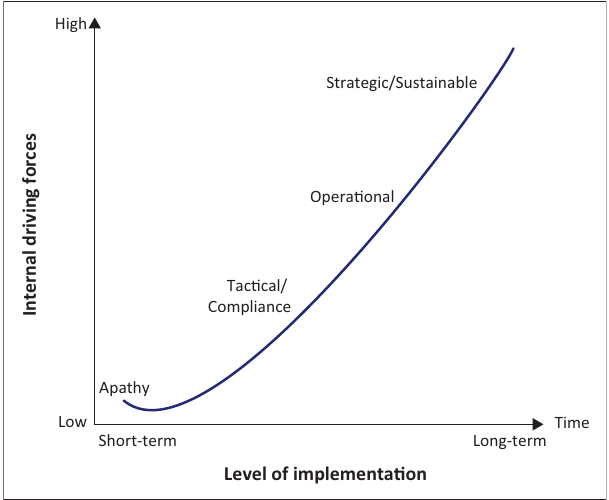
FIGURE 3: Influence of internal driving forces on level and time frame of